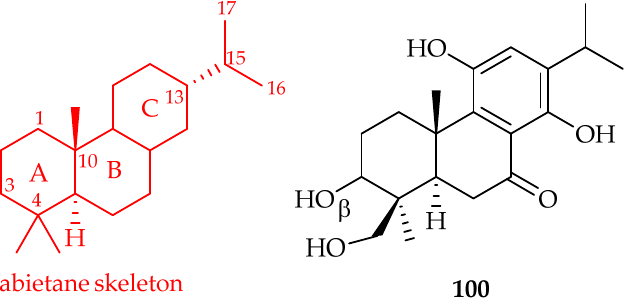
Figure 41. Structures of abietane skeleton and triregelin I 100 [63].